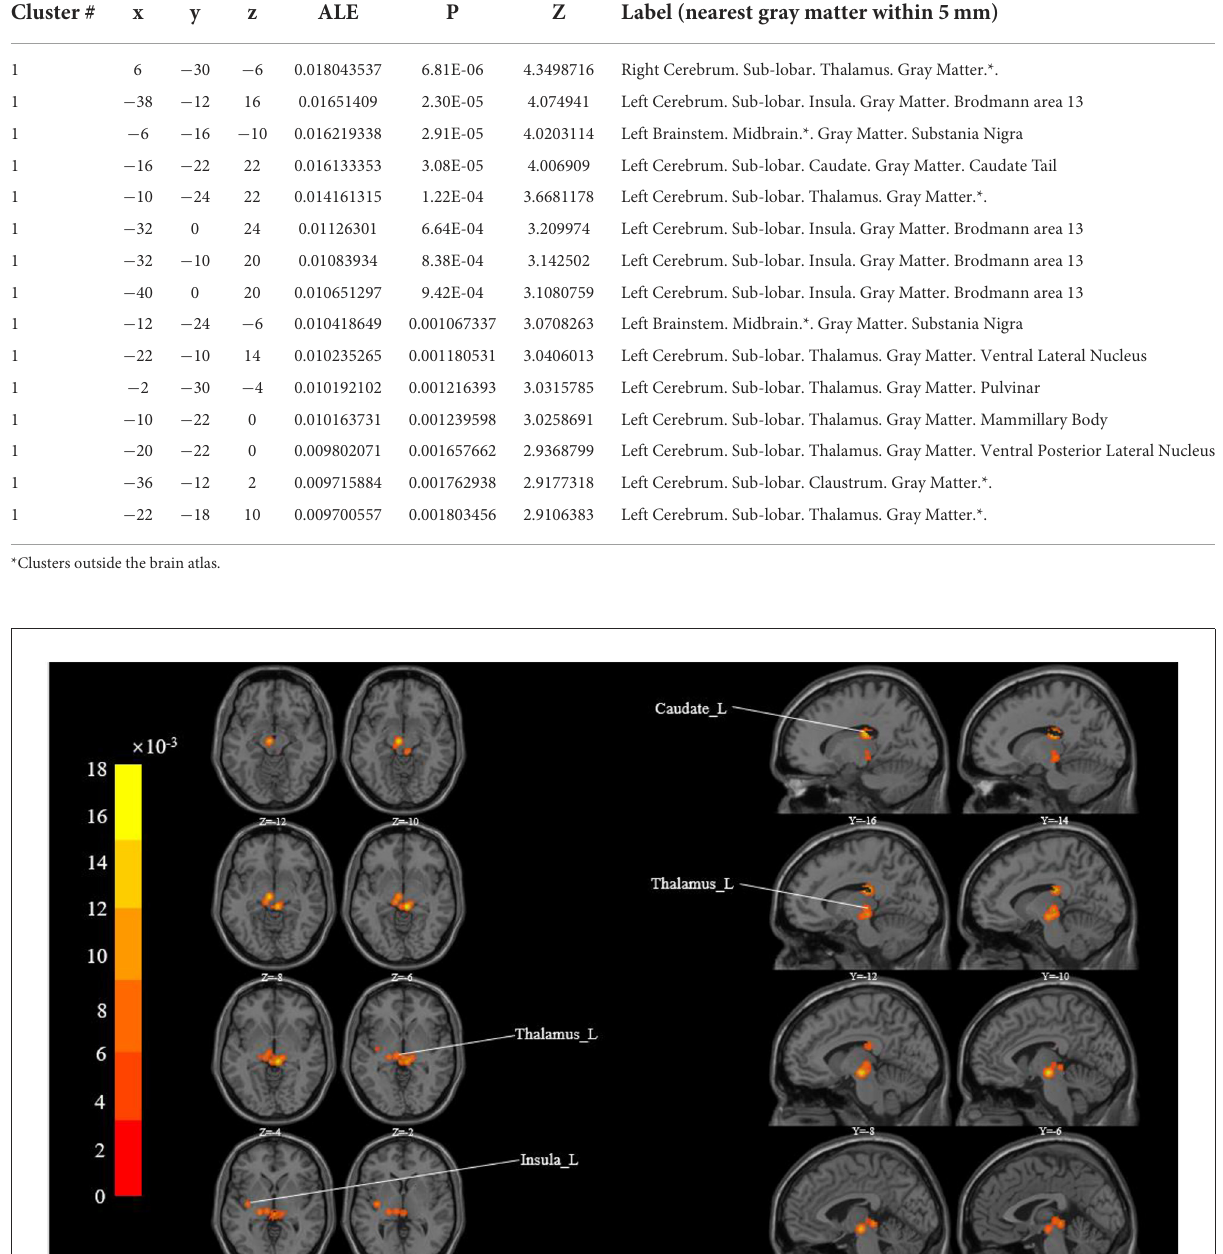
TABLE 3 All clusters from the ALE analysis.